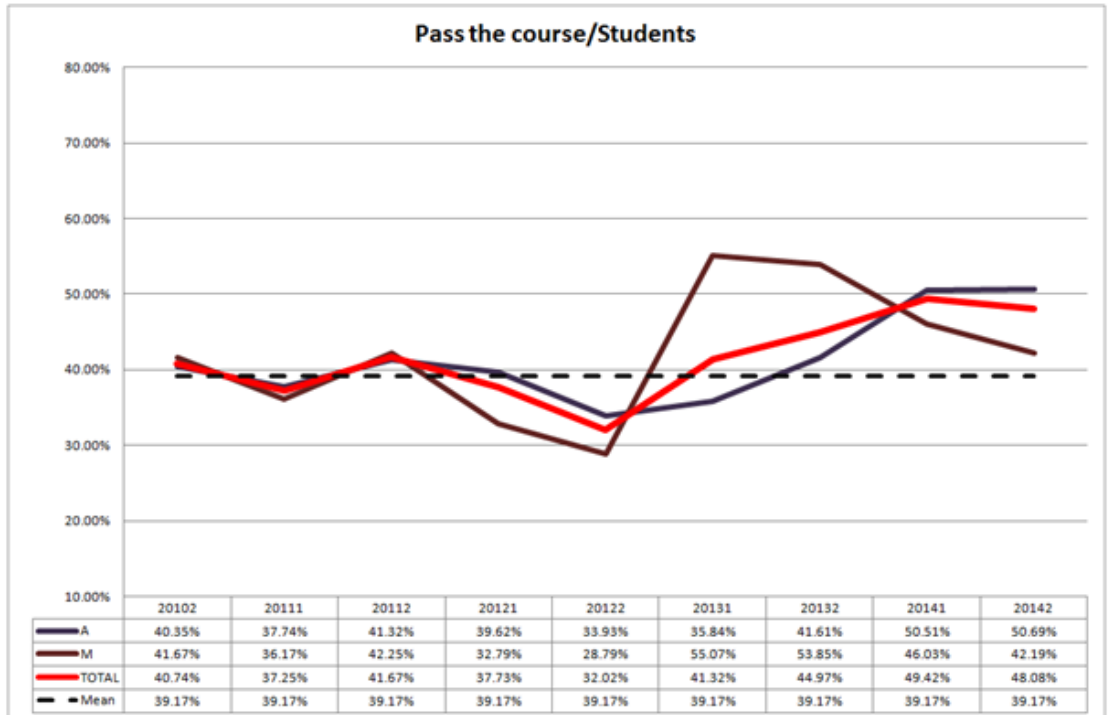
Figure 4. Students passing the course with respect to the total number of